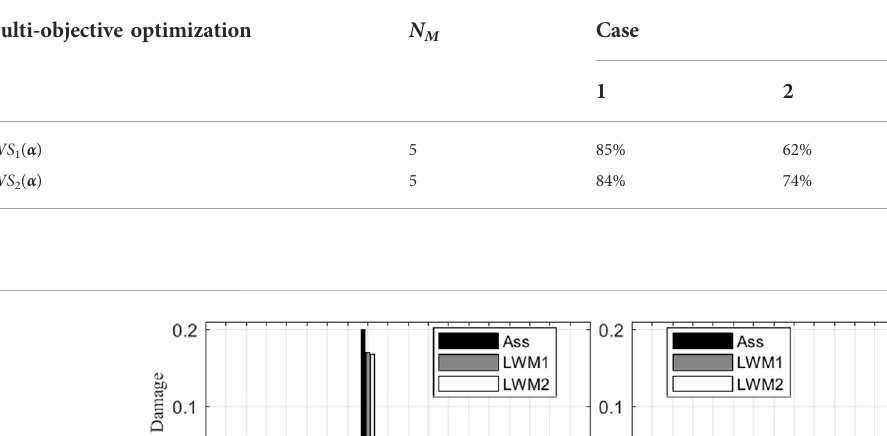
TABLE 5 DVC100 values of SDD results based on LWS 1 ( α ) and LWS 2 ( α ) with w = 0.1.